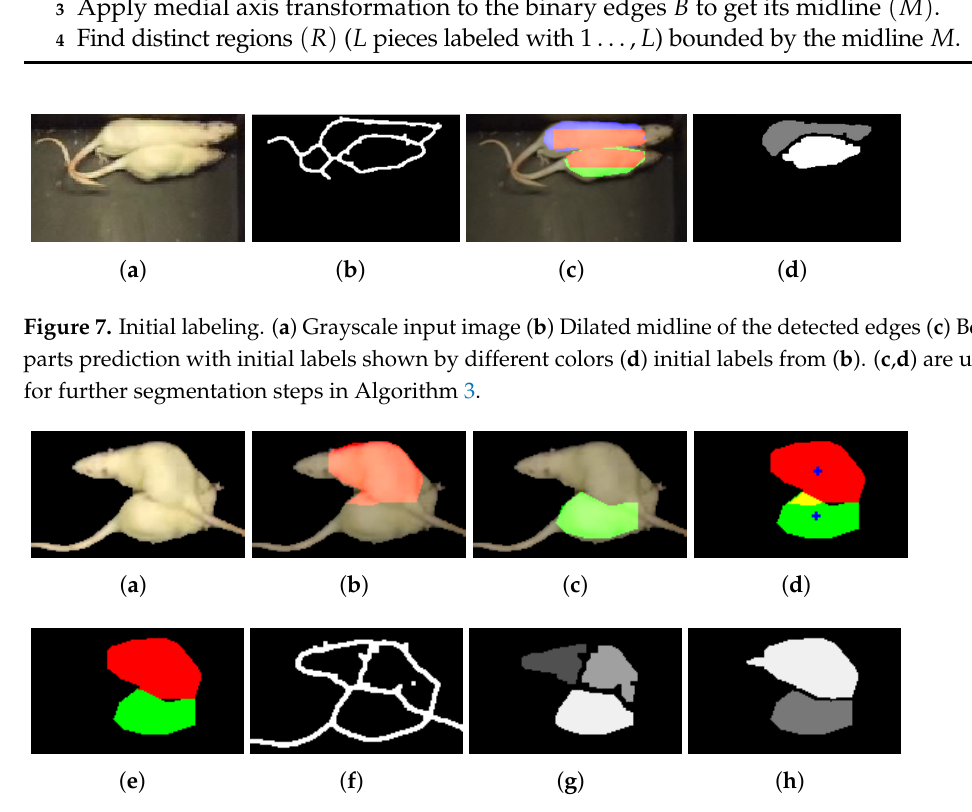
Figure 8. Due to identical appearances without any markers, region-based segmentation is often erroneous. If two bodies are predicted (shown in red and green), they are often overlapping, with non-realistic outlier contour points. We apply a centroid based method as a correction. ( a ) input; ( b ) first predicted body region; ( c ) second predicted body region; ( d ) both predicted body regions, yellow marks overlap, blue marks centroids; ( e ) after correction (each point in the intersection is assigned to the closest center of gravity); ( f ) edge midline Algorithm 2; ( g ) initial region labeling based on ( f ) and dilation; ( h ) region labeling combines ( e , g ) using Algorithm 3.